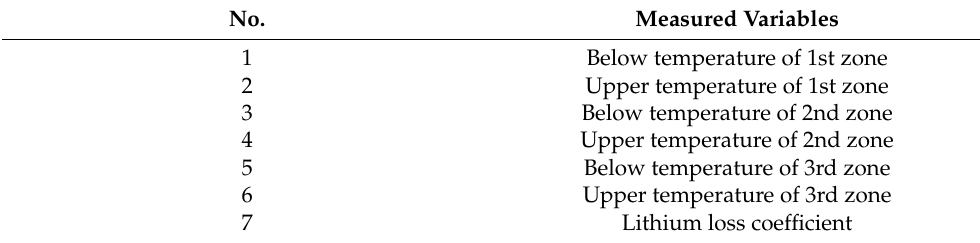
Table 1. Selected variables in the sintering